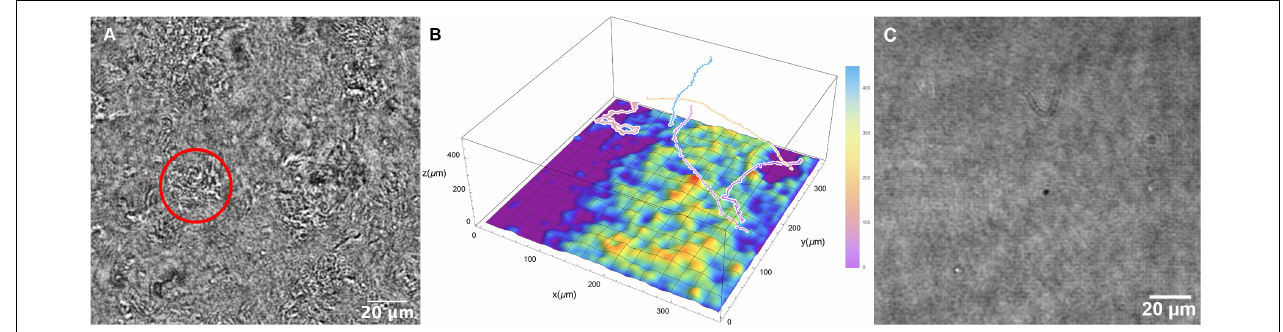
FIGURE 8 | Collections of non-motile cells on the chamber surface at 66 ◦ C. (A) Still image; the circle indicates a cluster of cells. (B) Schematic of surface clustered cells with relative positions of selected motile tracks. (C) Corresponding image of the slide surface with the killed cell dataset at 66 ◦